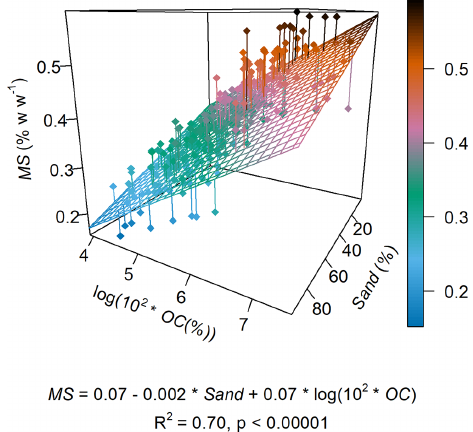
Figure A2. Pedotransfer function for estimating soil moisture at field capacity (MS) as a function of sand and organic carbon (OC) content. The regression was fit using only the data for the A hori- zons in the 265 agricultural soil profiles from the UK SOILPITS dataset used in this